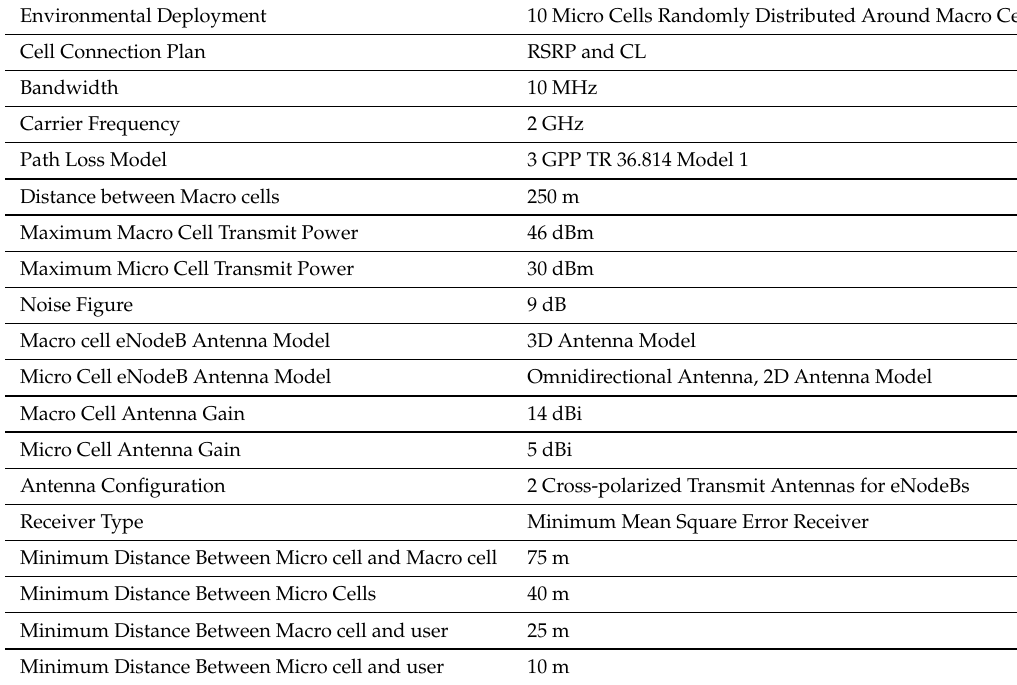
Table 1. Simulation parameters.